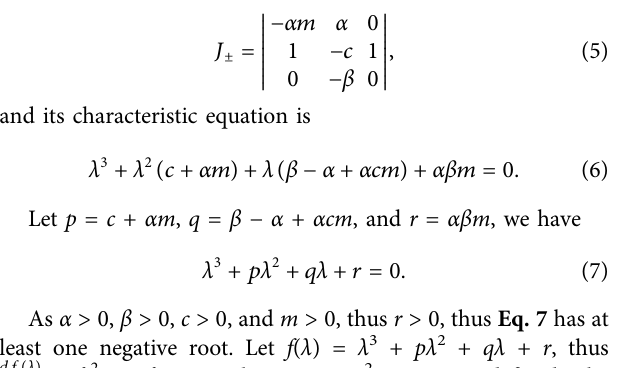
Figure 1 . For the bifurcation diagrams, the initial conditions for the red are [ x 0 , y 0 , z 0 ] (cid:1) [0.01, 0, 0.01]; the initial conditions for the blue is [ x 0 , y 0 , z 0 ] (cid:1) [ − 0.01, 0, − 0.01]. It shows that when α < 70, the system has coexisting attractors and enters to chaos through period doubling bifurcation. After this, the system has periodic windows with the increase of α . It indicates that the system has rich dynamics.